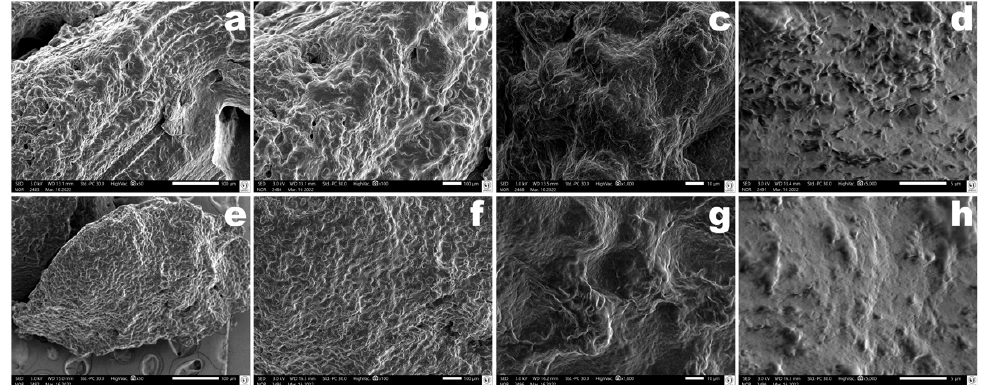
Figure 16. Photomicrographs of the vaginal egg surface at several magnifications (( a ): × 50, ( b ): × 100, ( c ): × 1000, ( d ): × 5000), and of the cross-section fracture zone (( e ): × 50, ( f ): × 100, ( g ): × 1000, ( h ): × 5000).